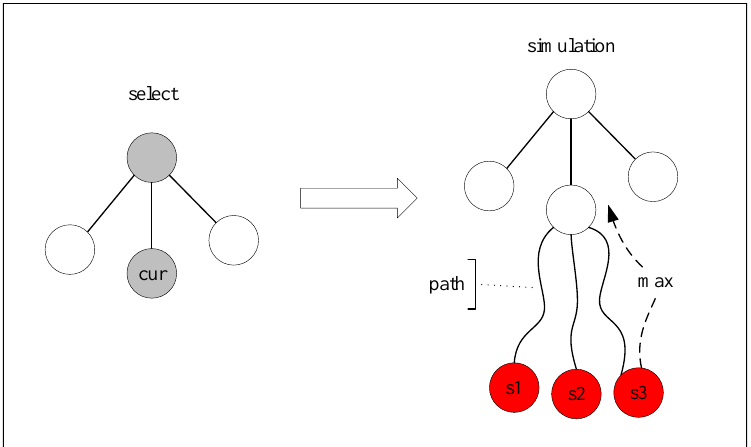
Figure 4. The improved MCTS simulation